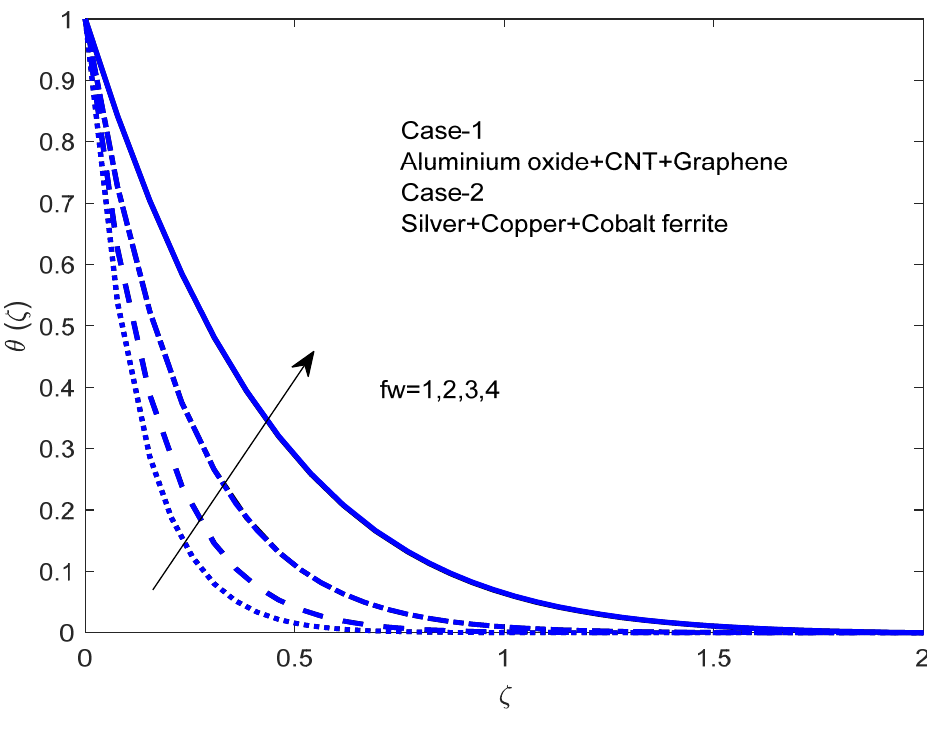
Figure 2. The effect of w f on the temperature profile.